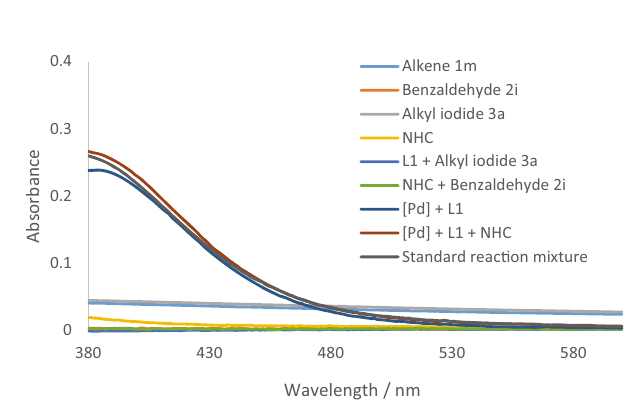
Fig.7|UV – Visibleabsorptionspectra. TheUV – Visabsorptionspectraofpossible combinations of the substrates and